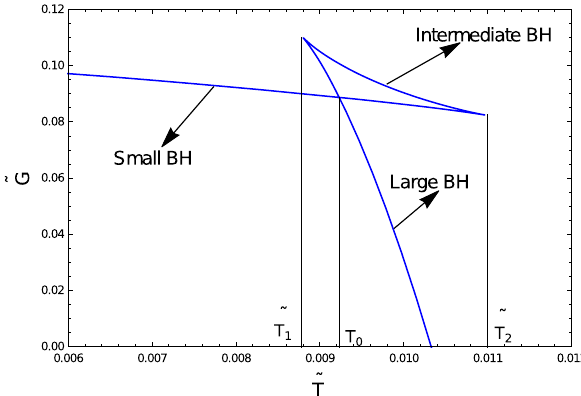
Fig. 8 The generic plot of Gibbs free energy ˜ G vs horizon ˜ T for ˜ P < ˜ P